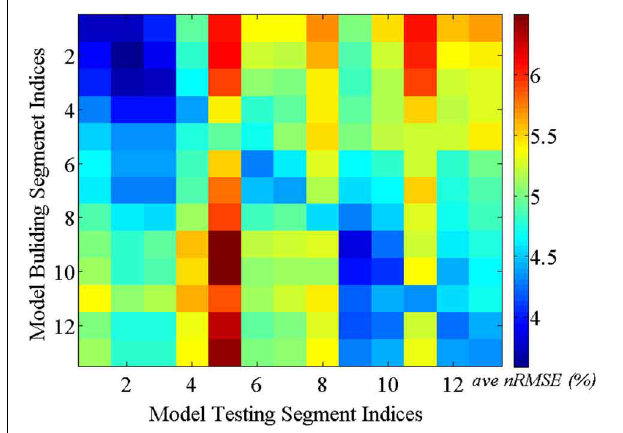
FIGURE 8 | BCG estimation errors ( ave nRMSE ) in percentage (%) exhibit (sub)diagonal structure for models built on one segment and applied to another